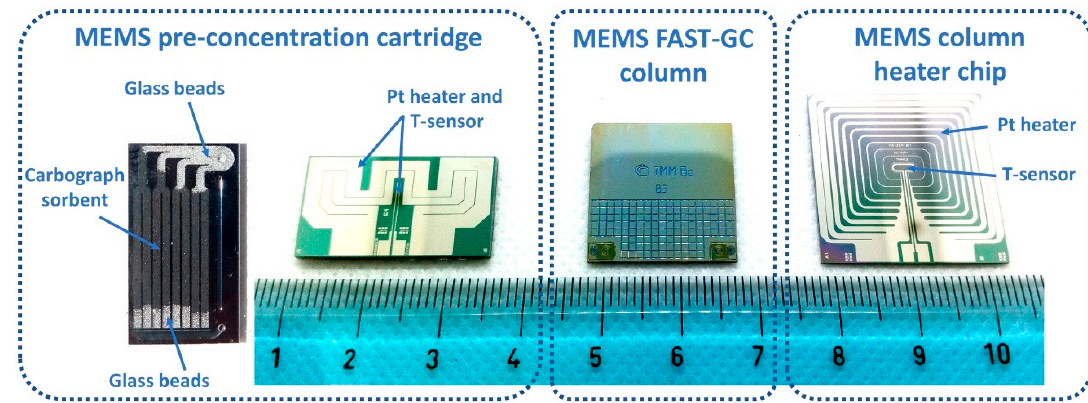
Figure 3. A packed Micro-Electro-Mechanical-System (MEMS) pre-concentrator ( left ) with backside integrated heater and temperature sensor, MEMS fast gas-chromatographic (FAST-GC) column